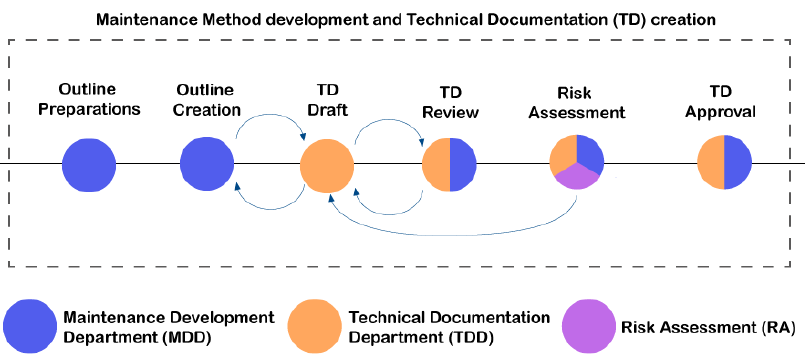
Figure 1. Maintenance documentation process.